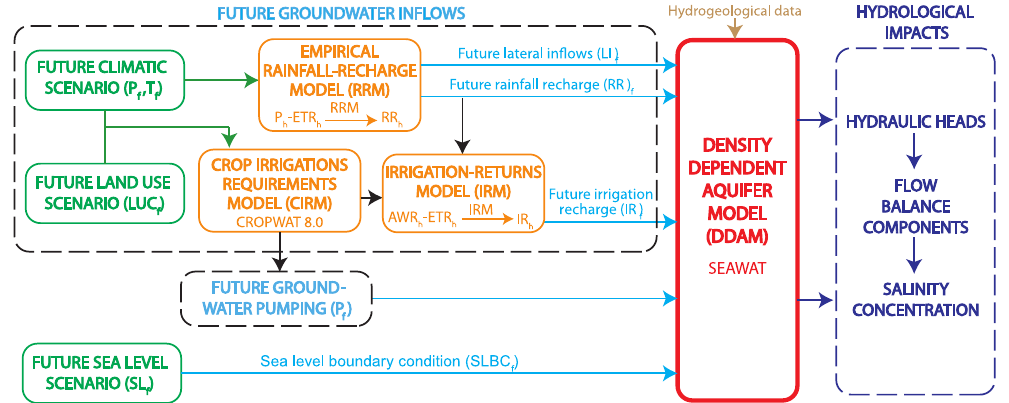
Figure 4. Flowchart of the modelling